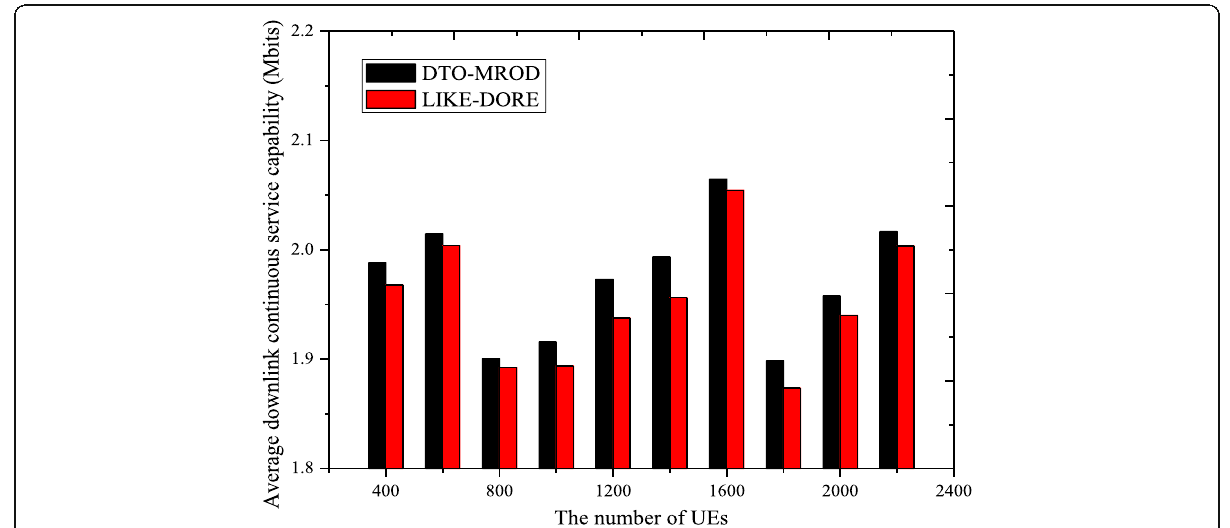
Fig. 7 Average downlink continuous service capability for the two schemes under the different numbers of